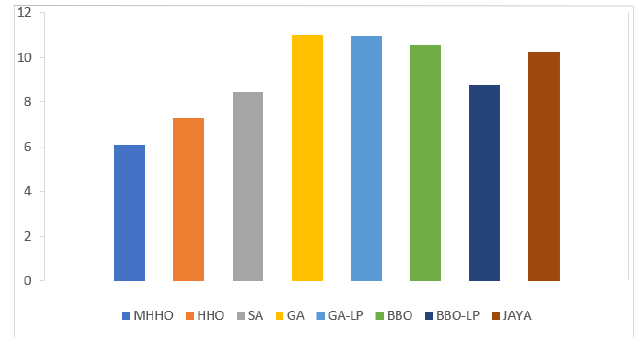
Figure 5. Algorithm-wise objective function comparison for 8-bus network. Table 5. Percentage of improvement by MHHO for 8-bus network.